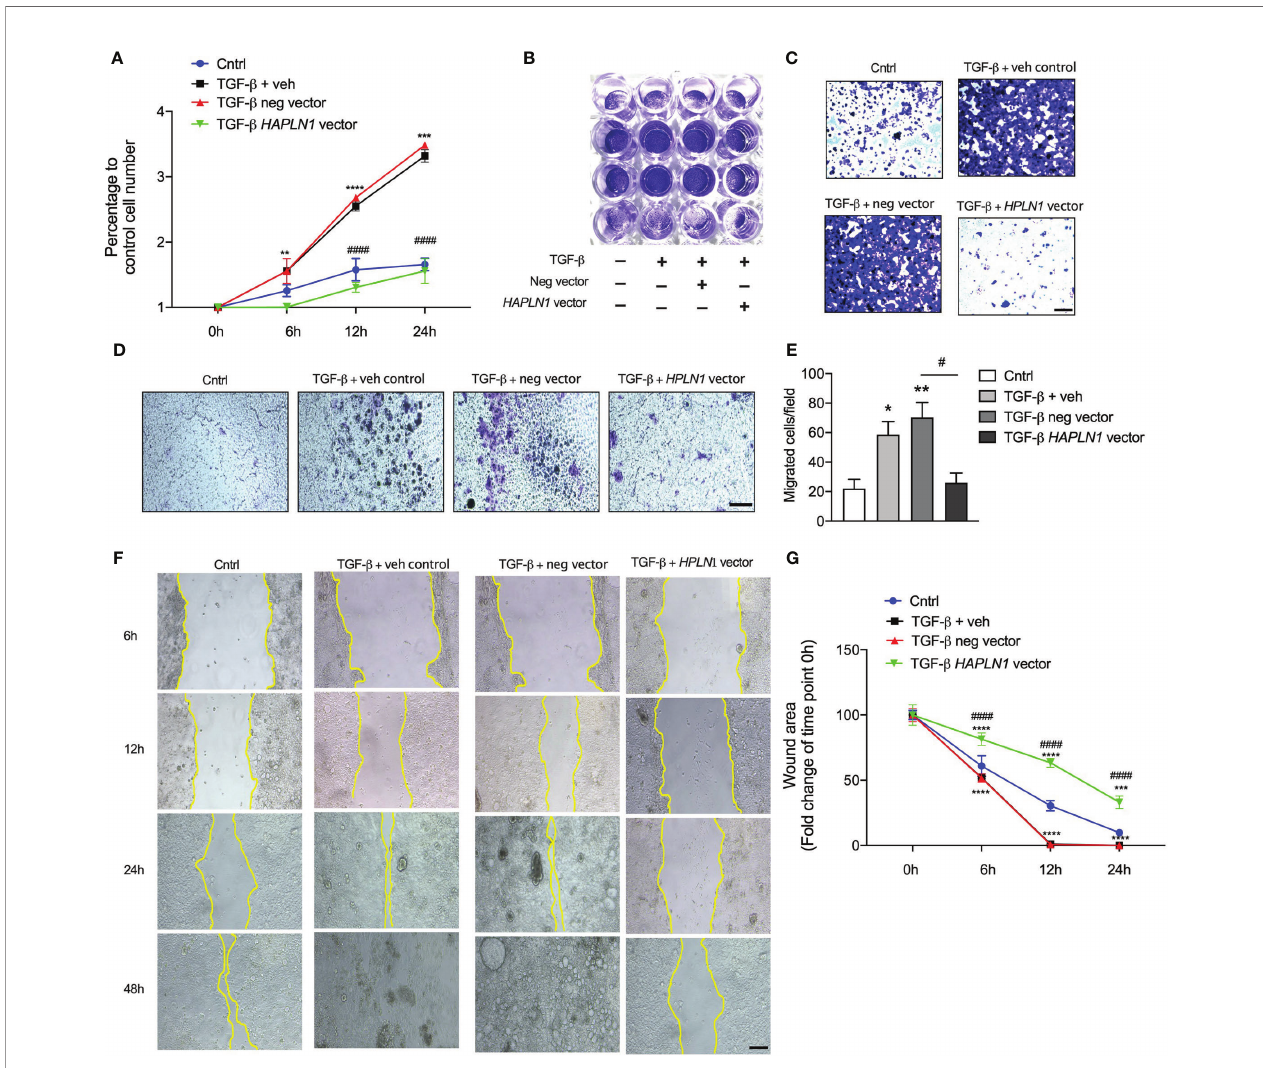
FIGURE 5 | HAPLN1 overexpression reduces tumor cell growth in colorectal cancer (CRC). Human CRC epithelial (Caco-2) cells were transfected with HAPLN1 overexpression or negative control plasmid, and vehicle controls received media. Cells were then challenged with human recombinant TGF- b protein. (A) Live cells were enumerated during the time course of TGF- b challenge (0, 6, 12, and 24 h) using a cell viability assay. (B) Cells were stained with crystal violet after 24 h of TGF- b challenge and (C) visualized using light microscopy (scale bar = 100 um). (D) Cell migration was assessed by boyden ’ s chamber assay after 24 hours TGF- b challenge that Caco-2 cells were stained with crystal violet (scale bar = 100 um) and (E) migrated were counted in at least 5 random fi elds per well under 20x magni fi cation lens by an inverted microscope. (F) Cell Scratch assays were performed in wells cultured with Caco-2 cells, and cancer cell invasion and migration were assessed by wound healing (scale bar = 200 um). (G) Wound area was assessed by measuring wound closure size after 0, 6, 12, and 24 h post-scratch. n = 4. Results are mean ± SEM. * P < 0.05, ** P < 0.01, *** P < 0.001, **** P < 0.0001 compared with control cells. # P < 0.05, #### P < 0.0001 compared with cells transfected with negative control